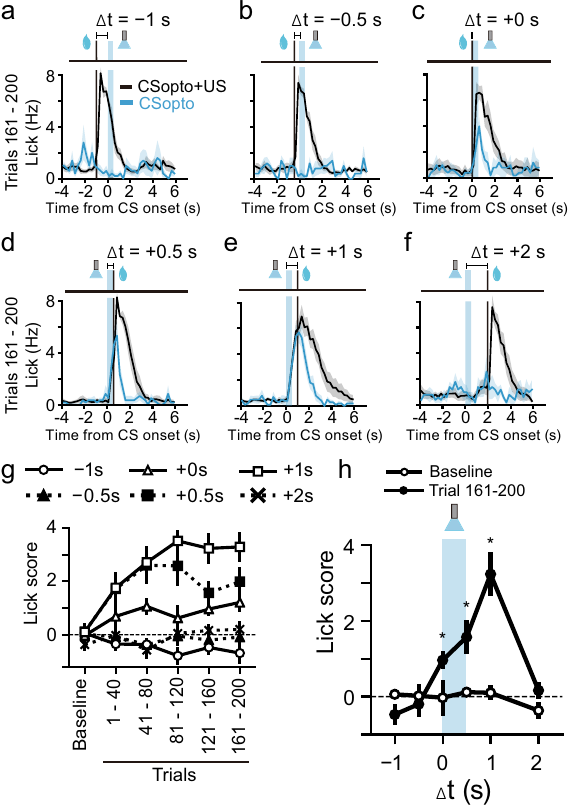
Figure 5. Various delays in US for CSopto conditioning. ( a – f ) Averaged PSTHs of the licking responses in conditioning with delays of Δt = − 1 s ( a , n = 5 mice), Δt = − 0.5 s ( b , n = 5 mice), Δt = + 0 s ( c , n = 5 mice), Δt = + 0.5 s ( d , n = 6 mice), Δt = + 1 s ( e , n = 10 mice), and Δt = + 2 s ( f , n = 5 mice) during 161–200 trials. ( e ) is the same plot as the bottom trace of Fig. 4f. ( g ) Lick scores plotted against time course for each condition. ( h ) Time window for conditioning. Lick scores in test trials or eight trials during trials 161–200 were plotted against delays between the CS and US. Wilcoxon signed-rank test. * P <